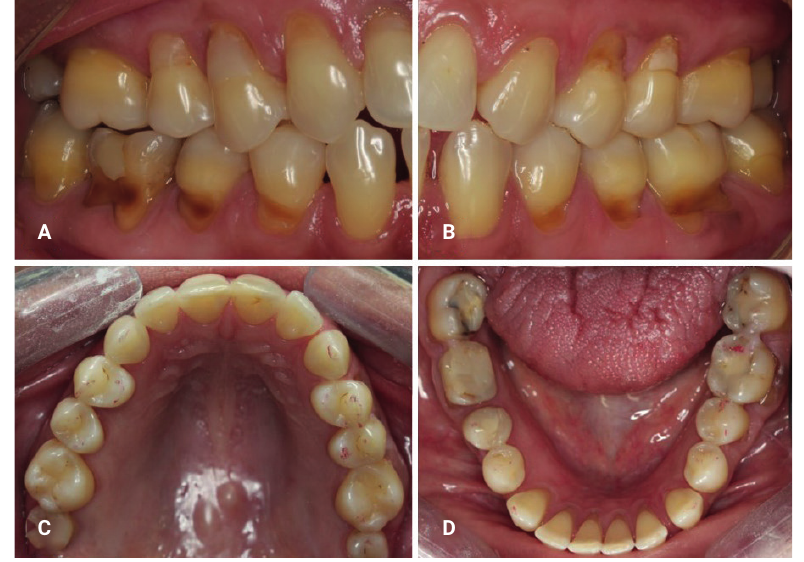
Figure 2. Initial clinical appearance of the posterior teeth. (a) NCCLs in the lower molars and premolars, superior canine and unsatisfactory restorations in the upper molar teeth. (b) NCCLs in the molars and premolars and unsatisfactory restorations in the upper second molar. (c) View of the occlusal contact points of maxillary teeth with excessive points of contact on the left side. (d) view of the occlusal contact points of the mandibular teeth with excessive points of contact on the posterior teeth on the left